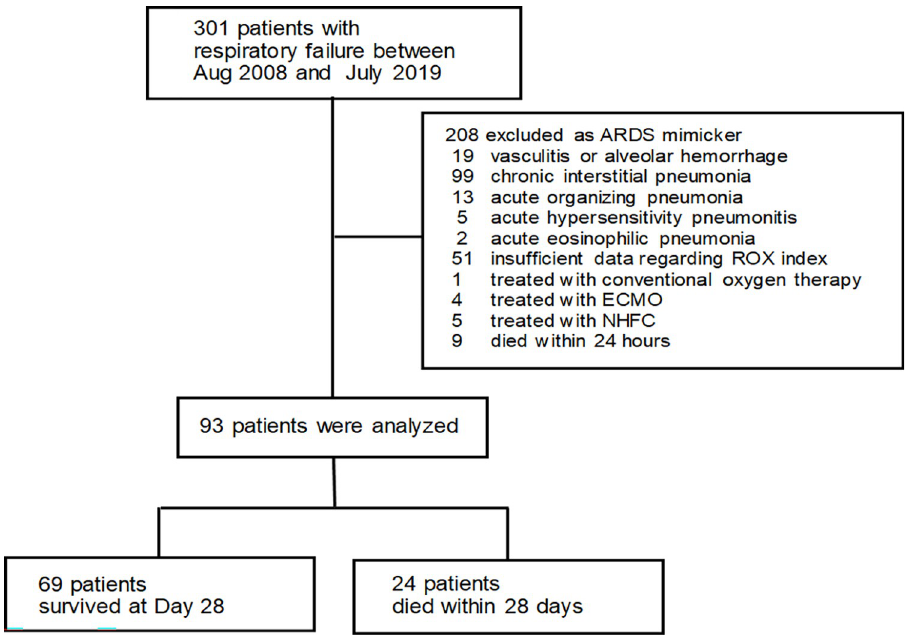
Fig 1. A flowchart showing patient inclusion, exclusion, and outcomes. ECMO: extracorporeal membrane oxygenation, ARDS: acute respiratory distress syndrome, NHFC: nasal high-flow cannula.